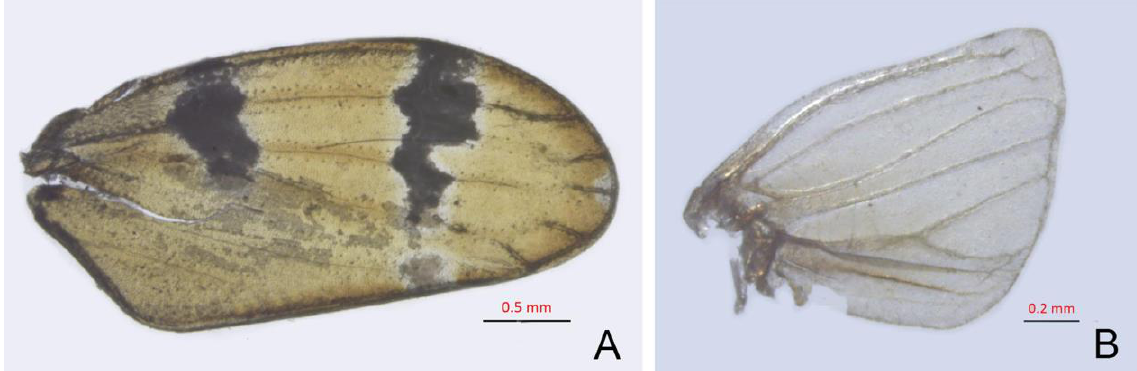
Figure 11. ( A , B ) Planaphrodes bifasciatus ♂ . ( A ) forewing. ( B ) hind wing.